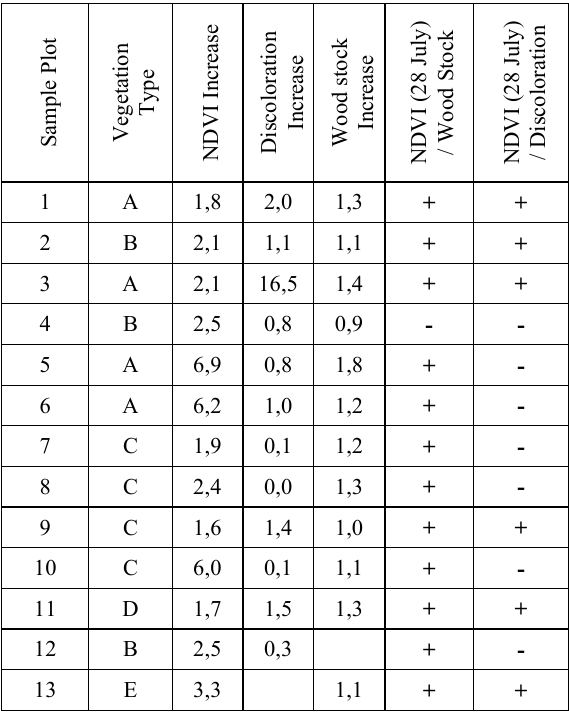
Table 2. Change of the NDVI, discoloration degree and wood stock. The positive signs mark the unidirectional changes, and the negative signs mark oppositely directed changes.